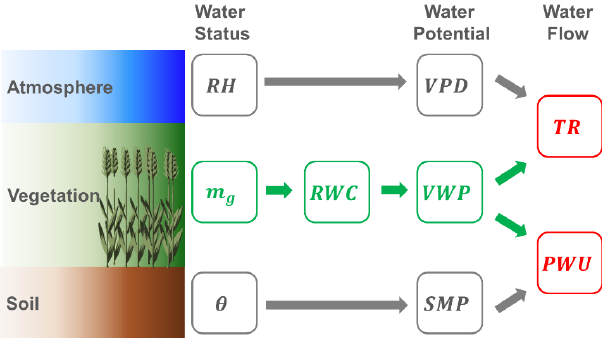
Figure 2. Processing workflow for estimation of soil, vegeta- tion, and atmosphere water potentials (SMP = soil matric poten- tial, RWC = relative water content of vegetation, VWP = vegetation water potential, VPD = vapor pressure deficit) and water fluxes (PWU = plant water uptake, TR = transpiration rate) from storage variables ( θ = soil moisture, m g = vegetation water content (gravi- metric), RH = relative air humidity). Green variables are derived from radiometer observations, while gray ones are calculated from in situ measurements; red variables are derived jointly from ra- diometer and in situ